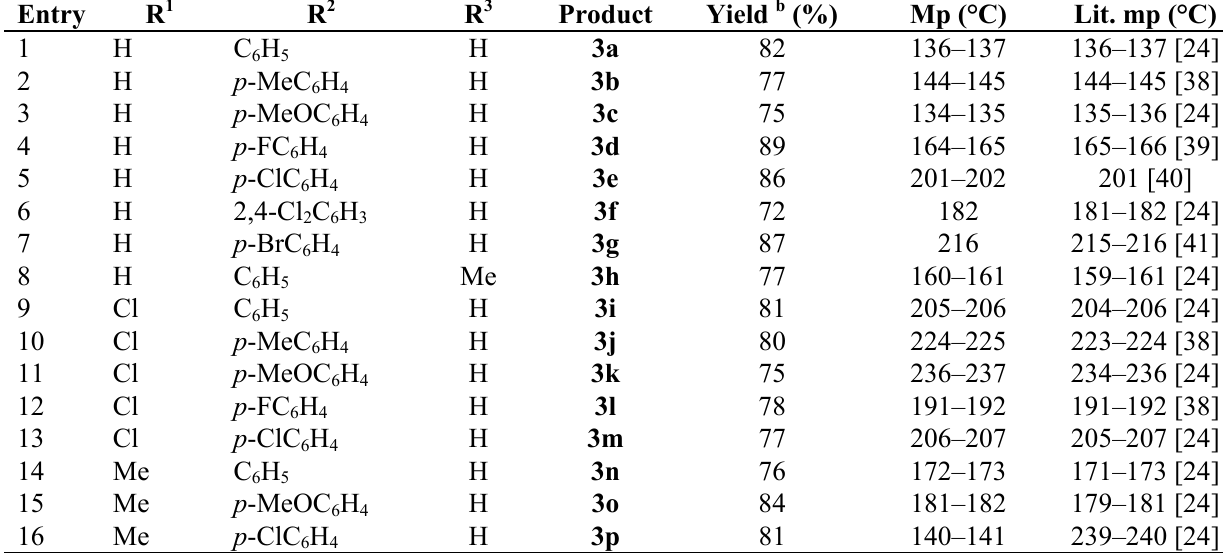
Table 1. Synthesis of 2-phenylimidazo[1,2- α ]pyridines from acetophenone, [Bmim]Br and 2-aminopyridine under solvent-free conditions a